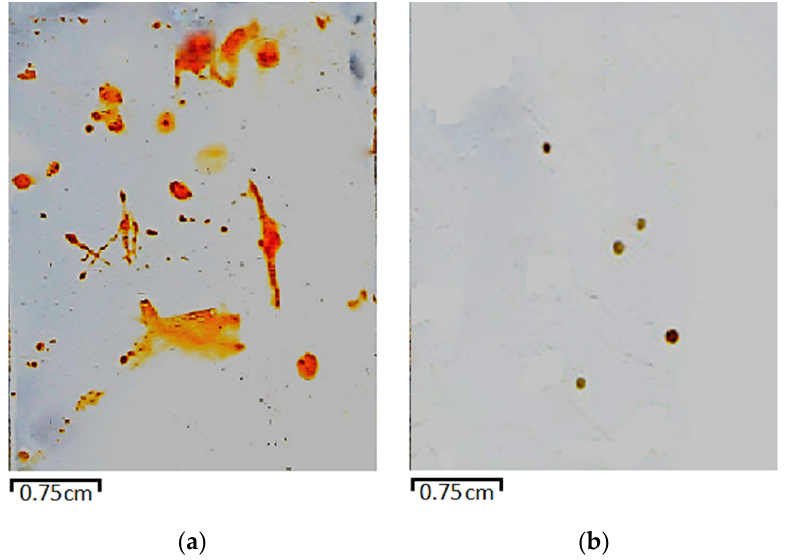
Figure 12. Appearance of the surface of steel samples after testing in a salt spray chamber for 24 h: ( a ) Clean HomaCryl coating; ( b ) HomaCryl + 0.01 M (VS + BTA) + 1% Strodex. Table 7. Percentage of corroded surface of steel samples with paint and varnish coatings. Sample Test Conditions